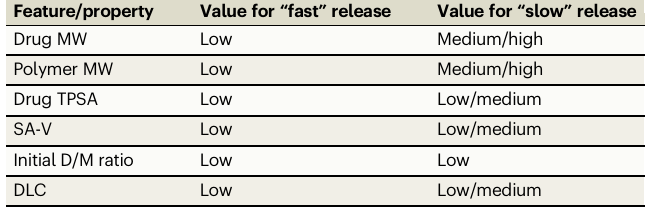
(and InitialD / Mratio )werewithintheLGBMmodel ’ sdesigncriteriafor the “ fast ” and “ slow ” release formulations. Speci fi cally, the DLC was <0.1 for the “ fast ” release formulation and >0.2 for the “ slow ” release formulation. For both the “ fast ” and “ slow ” systems, the values obtained for SA-V are indicative of spherical particle morphologies.